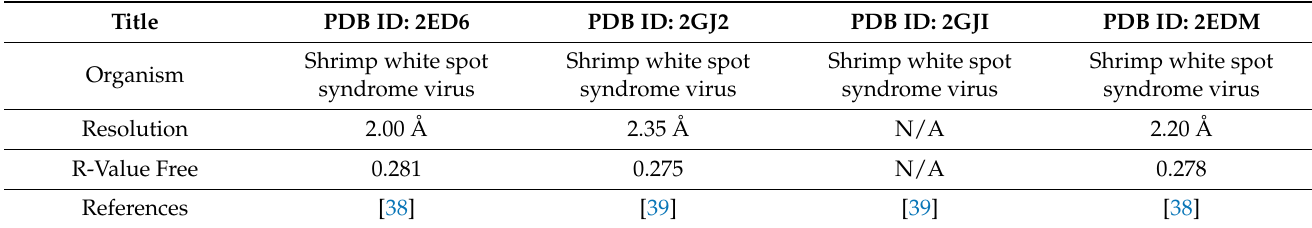
Table 1. Protein information in shrimp white spot syndrome